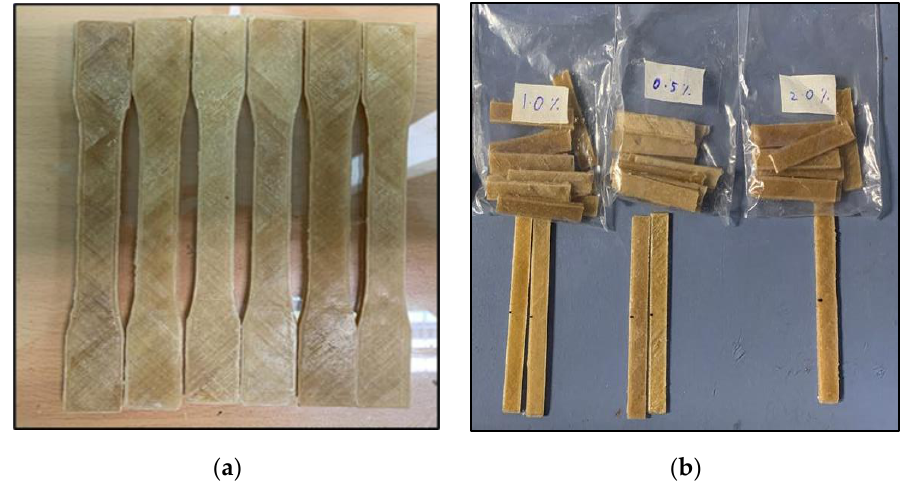
Figure 4. ( a ) Tensile specimens ( b ) Flexural specimens.